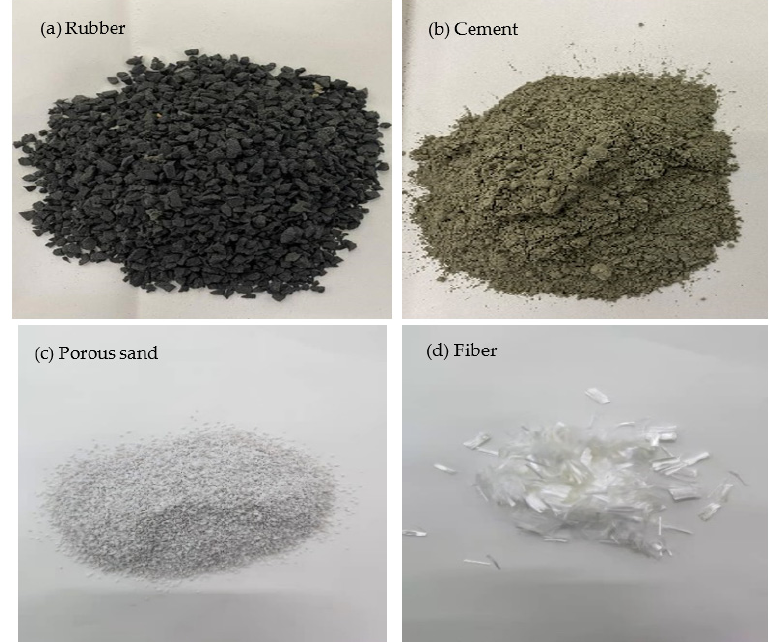
Figure 1. Profiles of rubber, cement, porous sand and fiber.